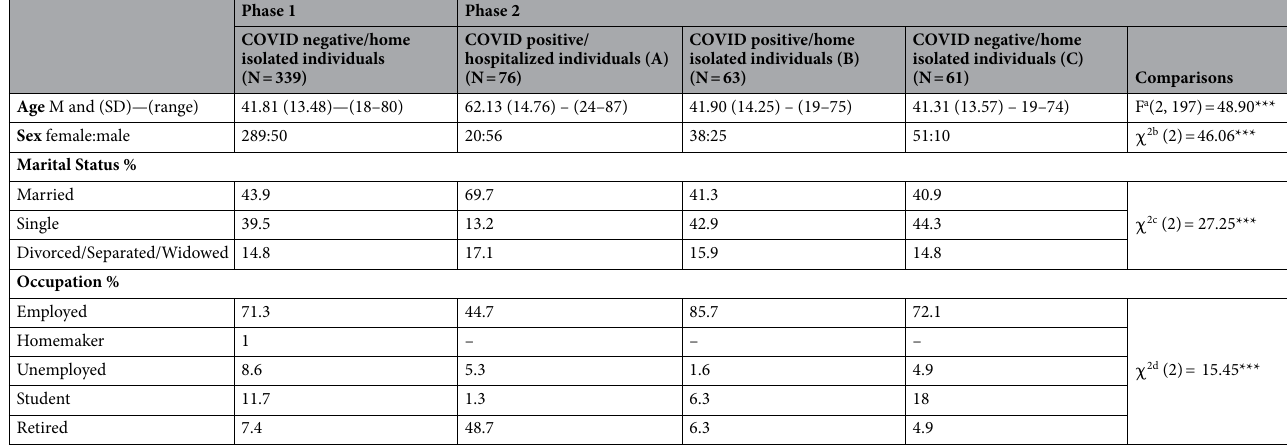
Table 1. Demographics of Phase 1 and Phase 2. SD = standard deviation; M = mean; * = p < .05; ** = p < .01; *** = p < .001. a = A group had age means higher than the other two groups that were not different from each other. b = A group had more men than the expected, while C group had more women than the expected. c = Comparisons based on risk groups and marital status dummy coded (presence vs. absence of a partner): high-risk group had a partner more than the expected. d = Comparisons based on risk groups and occupation dummy coded (employed vs. unemployed): high-risk group had no occupation more than the